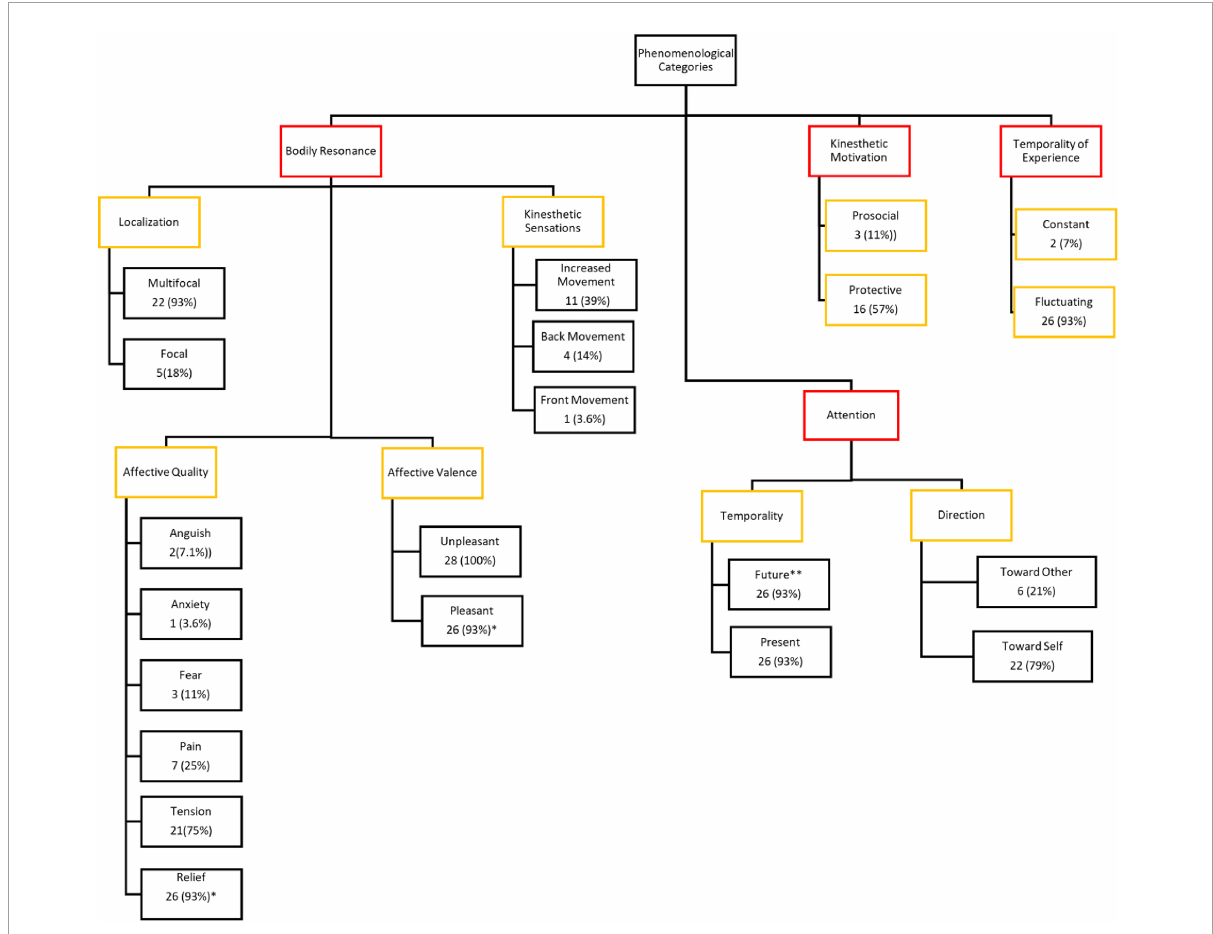
FIGURE1 Representative scheme of the experiential categories found in empathy for pain. Categories in red show the main themes, categories in yellow show the sub-themes, and categories in black show sub-categories. N (%) represents the number and percentage of participants who described the experience. ∗ Experience specifically identified in the recovery phase. ∗∗ Experience specifically identified in the anticipatory phase.